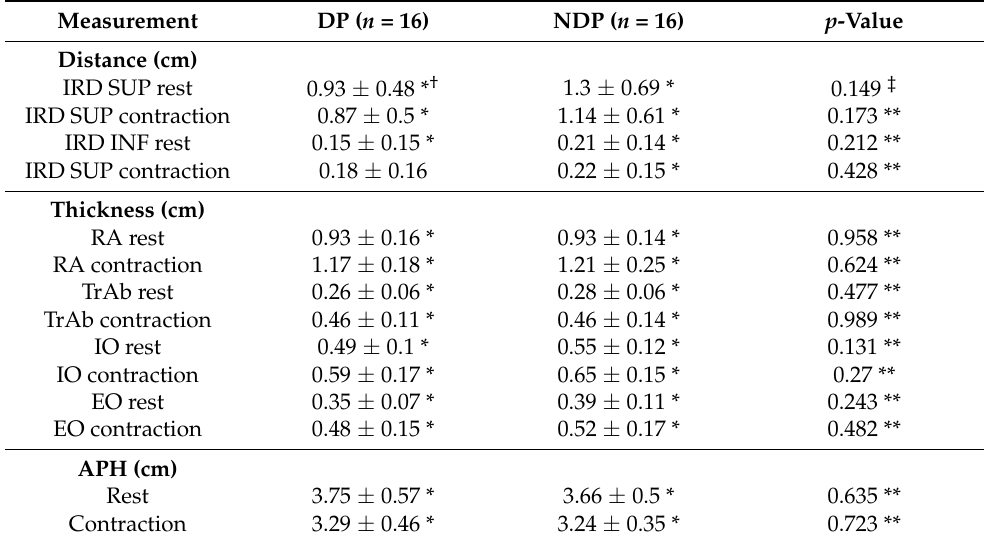
Table 2. Ultrasound imaging of the abdominal wall and pelvic floor